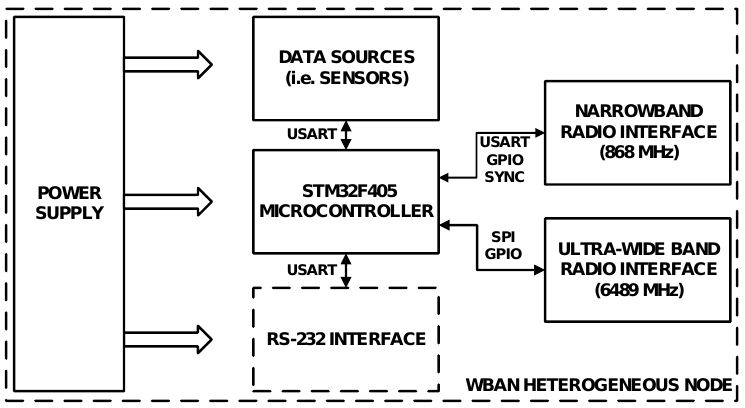
Figure 1. A block diagram of the MN.